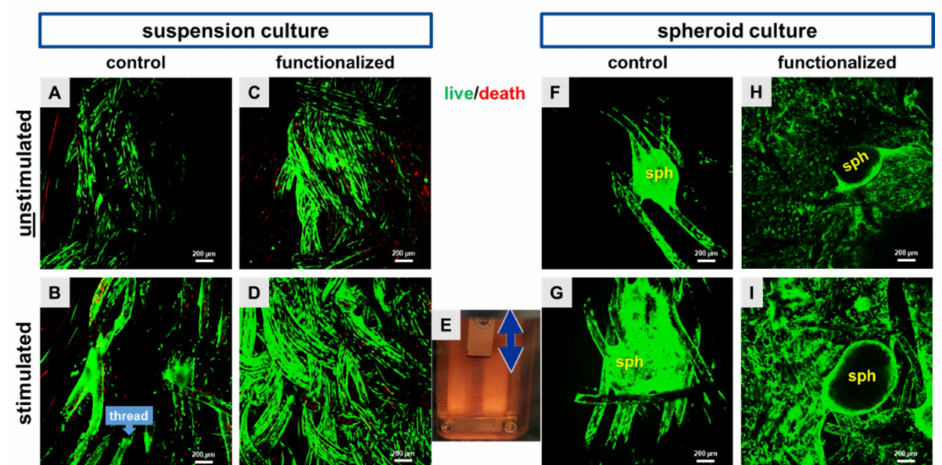
Figure 2. Representative scaffold pictures after the vitality assay, where live cells were depicted in green and dead cells were depicted in red. Both pre-cultivation strategies, the dynamical cell suspension (24 h) and the statical spheroid colonization (5 days) were performed on control scaffolds ( A , B , F , G ) and on functionalized scaffolds ( C , D , H , I ). Unstimulated ( A , C , F , H ) scaffolds were compared with stimulated (72 h, 4% stretch, 0.11 Hz, ( B , D , G , I )) ones. A scaffold inside the stretch device ( E ) is shown, the double-headed arrow marks the stretch direction. Scale bars: 200 µ m. Three independent experiments with cells of three different donors were performed.